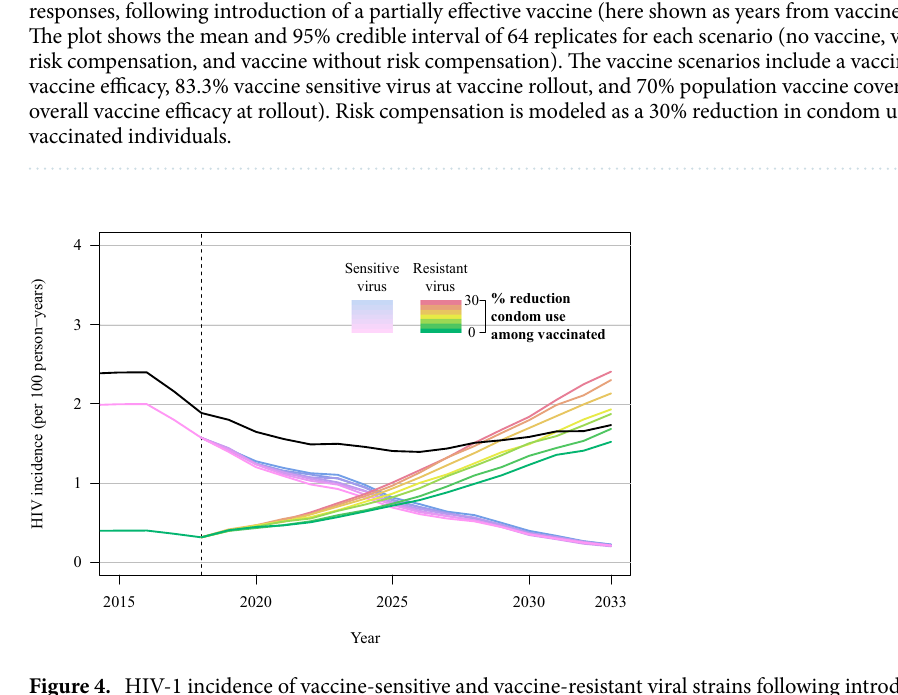
Figure 4. HIV-1 incidence of vaccine-sensitive and vaccine-resistant viral strains following introduction of a partially effective vaccine in the year 2018 (dashed vertical line), with 50% overall vaccine efficacy and 70% vaccine coverage. Model scenarios include variation in the reduction in condom use among vaccinated individuals (from 0 to 30% reduction). The mean and 95% credible interval of 64 replicates of each scenario are shown. Black line shows total incidence (incidence from sensitive and resistant viruses